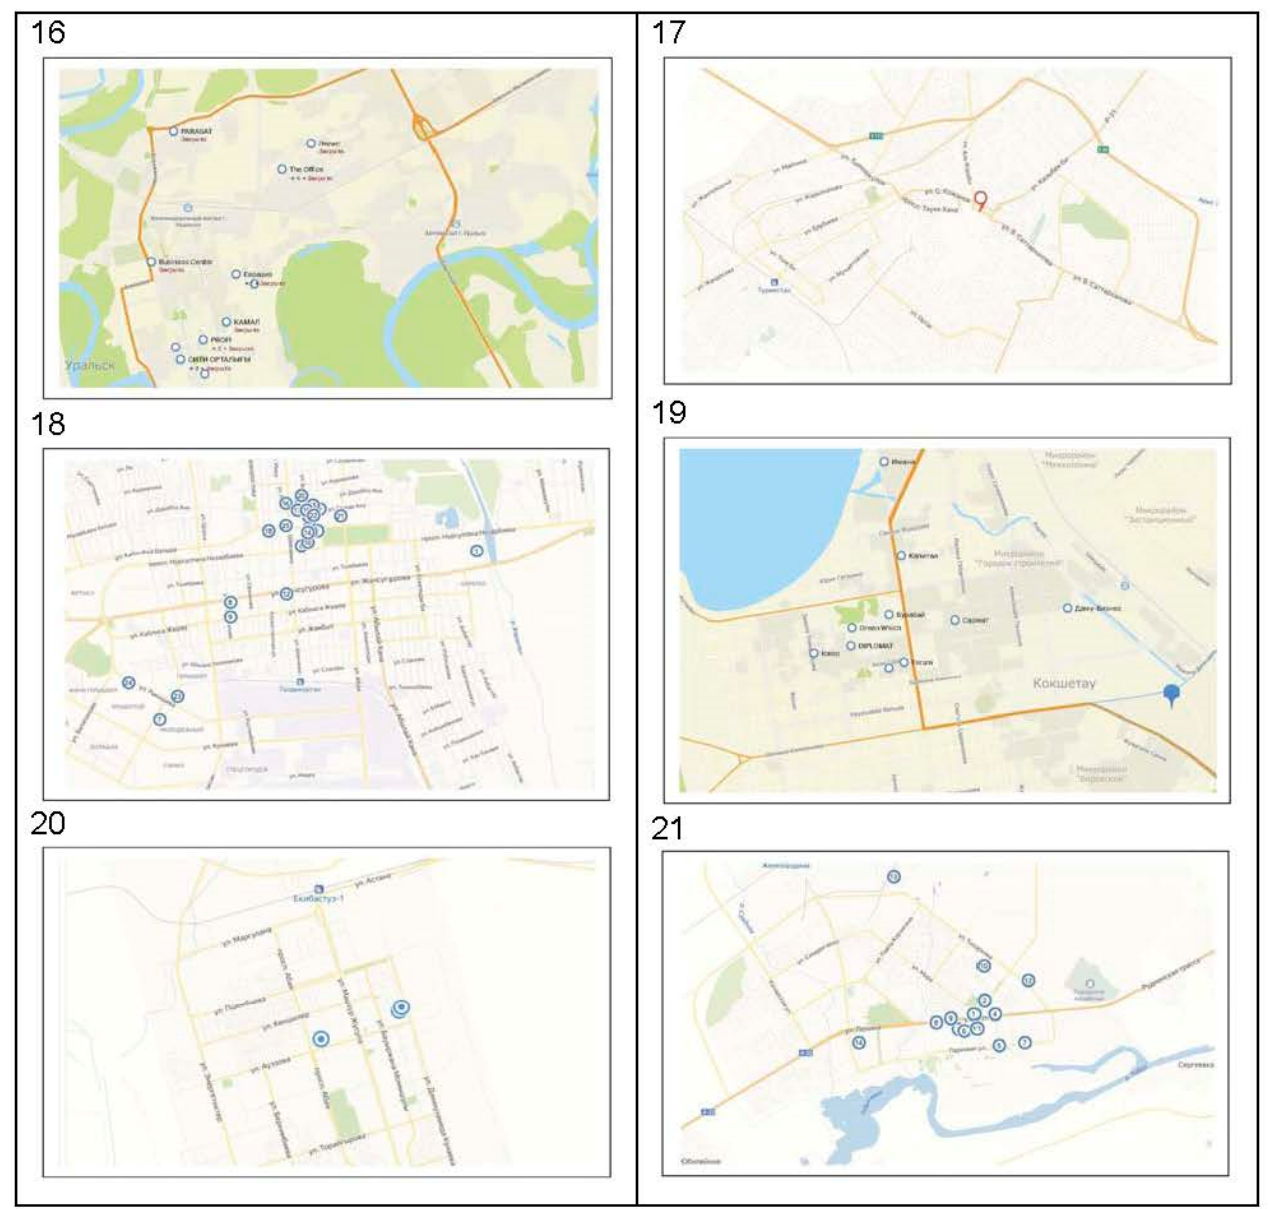
Figure 6. The locations of the main business centers in the city structure: ( 16 ) Ural’sk [90]; ( 17 ) Turkestan [91]; ( 18 ) Taldykorgan [92]; ( 19 ) Kokshetau [93]; ( 20 ) Ekibastuz [94]; and ( 21 ) Rudnyi [95].